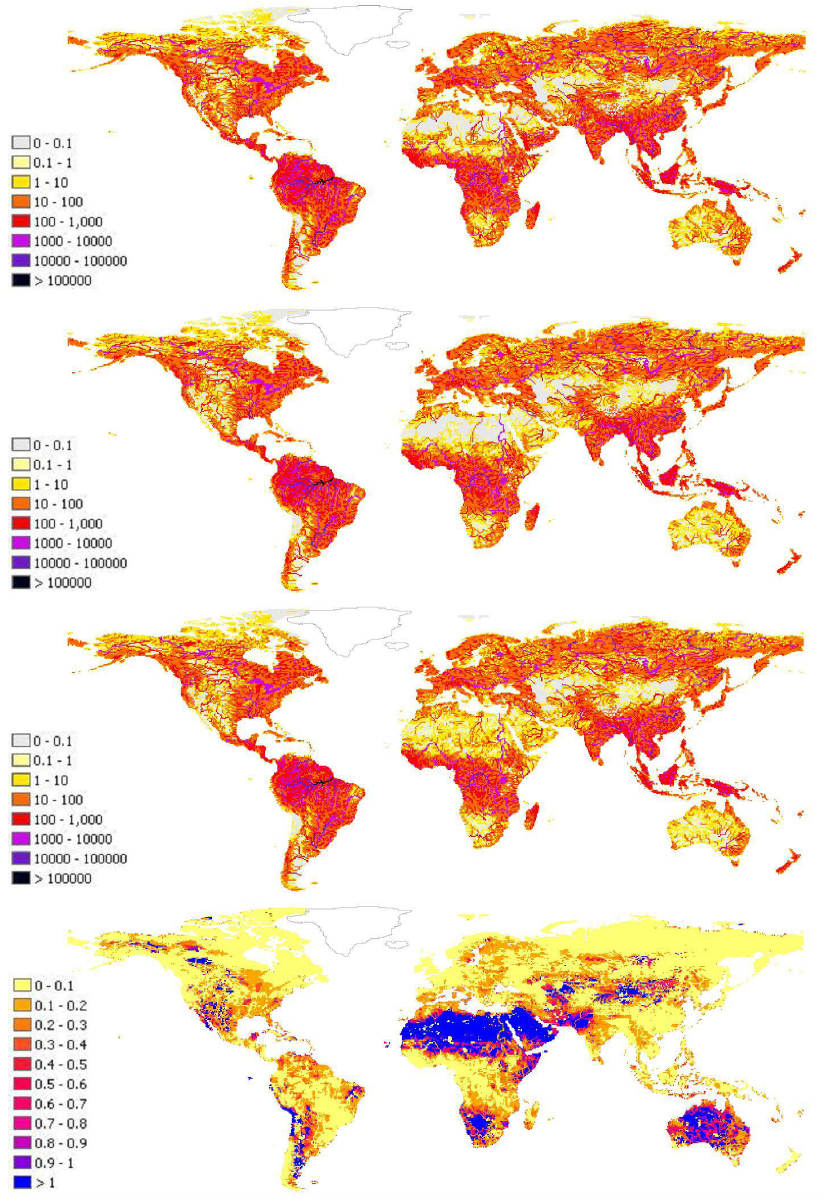
Figure 9: Thirty year average mean discharge (m 3 /s) calculated from a) the PCR-GLOBWB2 Fig. 9. Thirty year average mean discharge (m 3 /s) calculated from (a) the PCR-GLOBWB run forced with the ERA6190 dataset, (b) the run forced with the ERA6190 dataset, b) the PCR-GLOBWB run forced with the ERACLM 3 PCR-GLOBWB run forced with the ERACLM dataset, (c) the ensemble mean discharge results of the 12 GCM based PCR-GLOBWB runs dataset, c) the ensemble mean discharge results of the 12 GCM based PCR-GLOBWB runs4 and (d) the CV (–) of the thirty year average discharges of the ensemble of and d) the CV (-) of the thirty year average discharges of the ensemble of GCMs.5